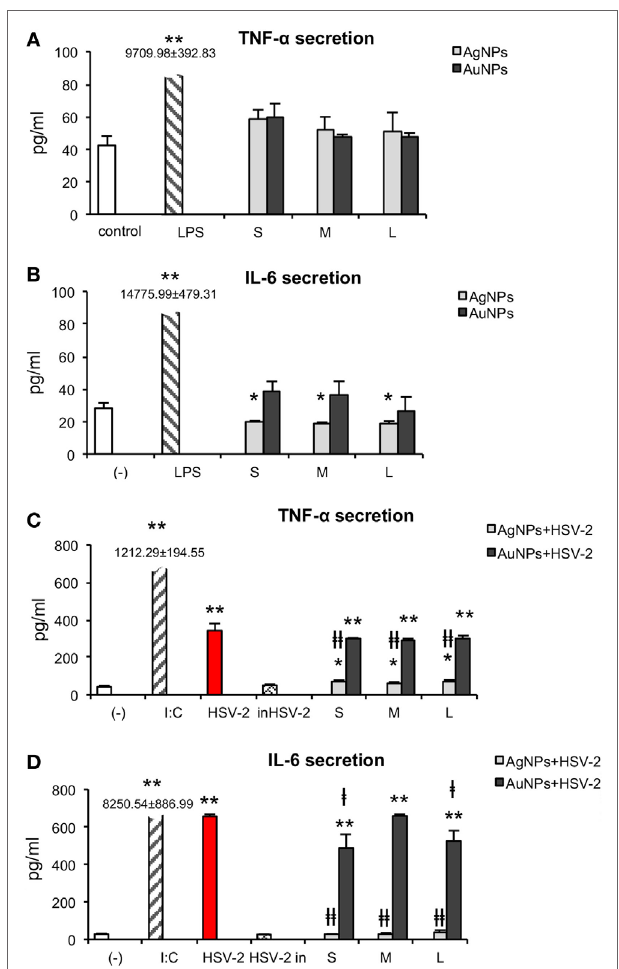
FigUre 10 | Effect of nanoparticles (NPs) and NPs-treated-HSV-2 on cytokine secretion. TNF- α (a) and IL-6 (b) production in JAWS II cells exposed to 2.5 µg/ml NPs for 24 h. (c) TNF- α and (D) IL-6 production in JAWS II cells exposed to NPs-treated HSV-2 for 24 h. Each bar represents the mean from 3 experiments ( N = 3) ± S.E.M. *Significant differences with p ≤ 0.05, ** p ≤ 0.01 in relation to untreated control, ǂ p ≤ 0.05, and ǂǂ p ≤ 0.01 calculated in relation to the HSV-2 infected